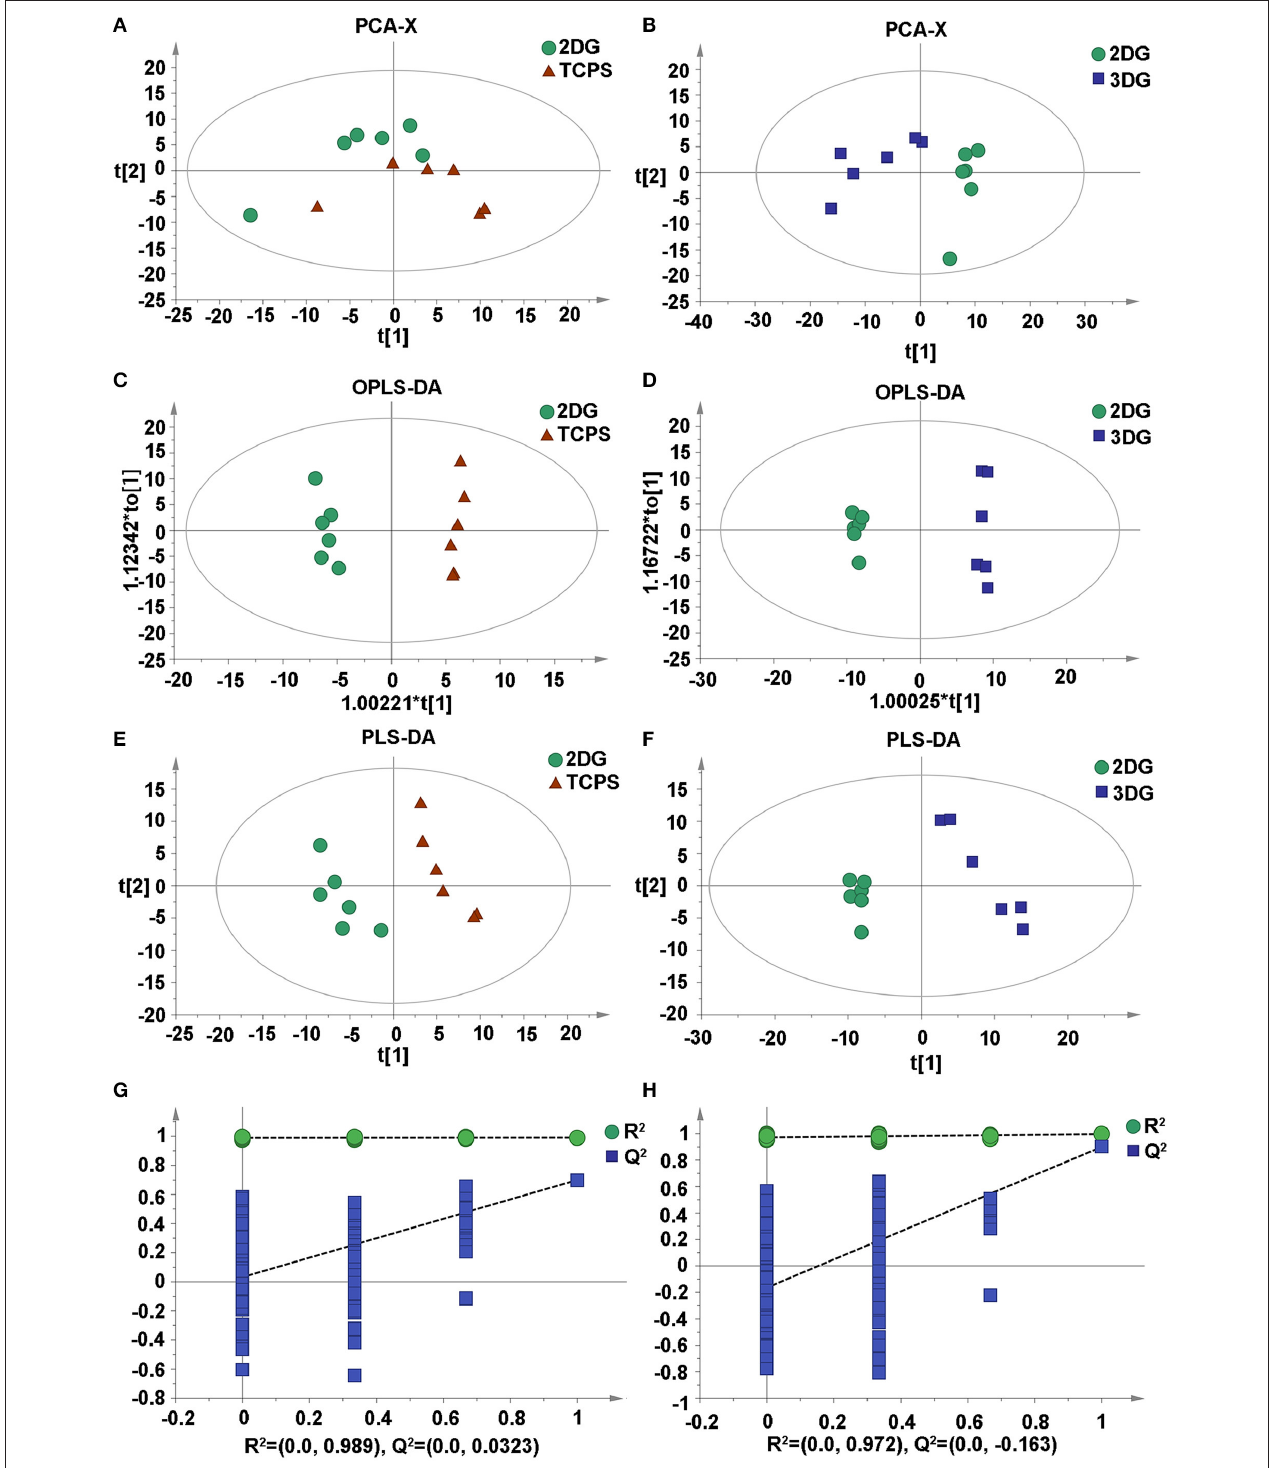
FIGURE 3 | Multivariate statistical score graph among three groups. (A) PCA score plot of 2DG and TCPS. (B) PCA score plot of 3DG and 2DG. (C) OPLS-DA score plot of 2DG and TCPS. (D) OPLS-DA score plot of 3DG and 2DG. (E) PLS-DA score plot of 2DG and TCPS. (F) PLS-DA score plot of 3DG and 2DG. (G) Statistical validation with permutation analysis (200 times) of the corresponding PLS-DA model of 2DG and TCPS, R 2 is the explained variance, and Q 2 is the predictive ability of the model. (H) Statistical validation with permutation analysis (200 times) of the corresponding PLS-DA model of 3DG and 2DG, R 2 is the explained variance, and Q 2 is the predictive ability of the